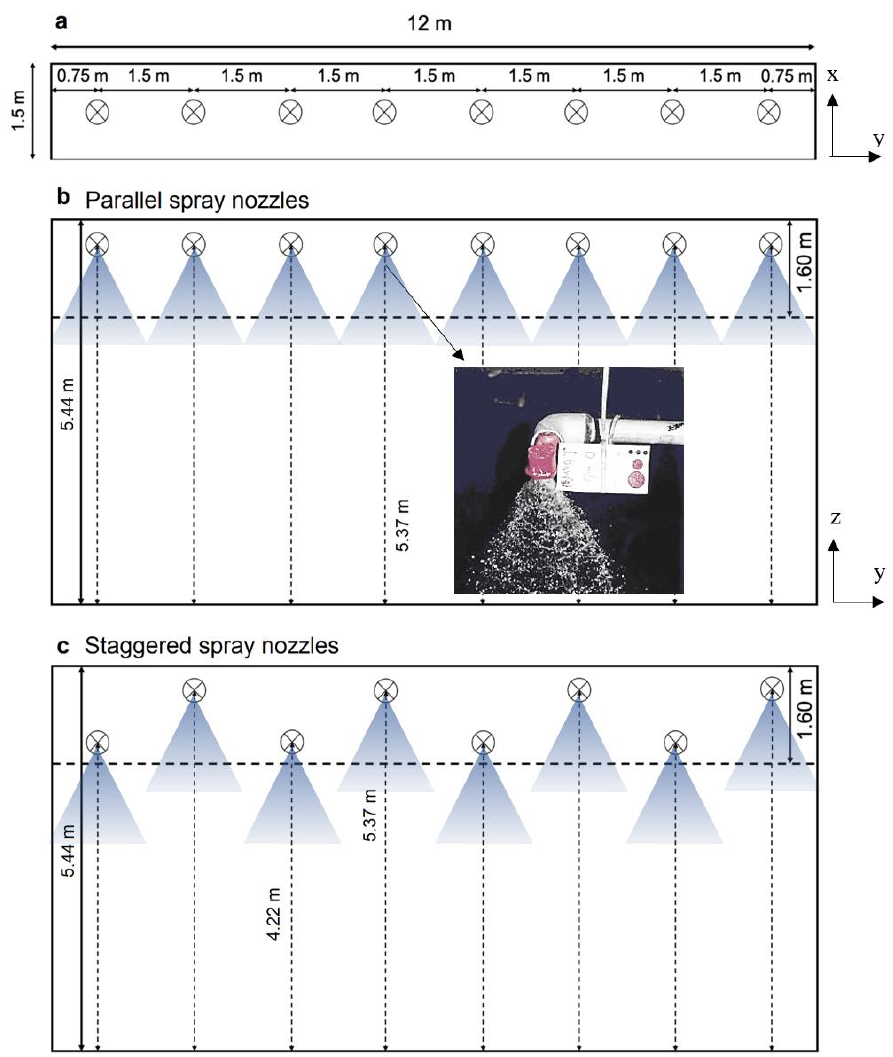
Figure 4. ( a ) Top view of the eight jet spray nozzle layout; ( b ) Front view of the eight jet spray nozzle parallel layout; ( c ) Front view of the eight jet spray nozzle staggered